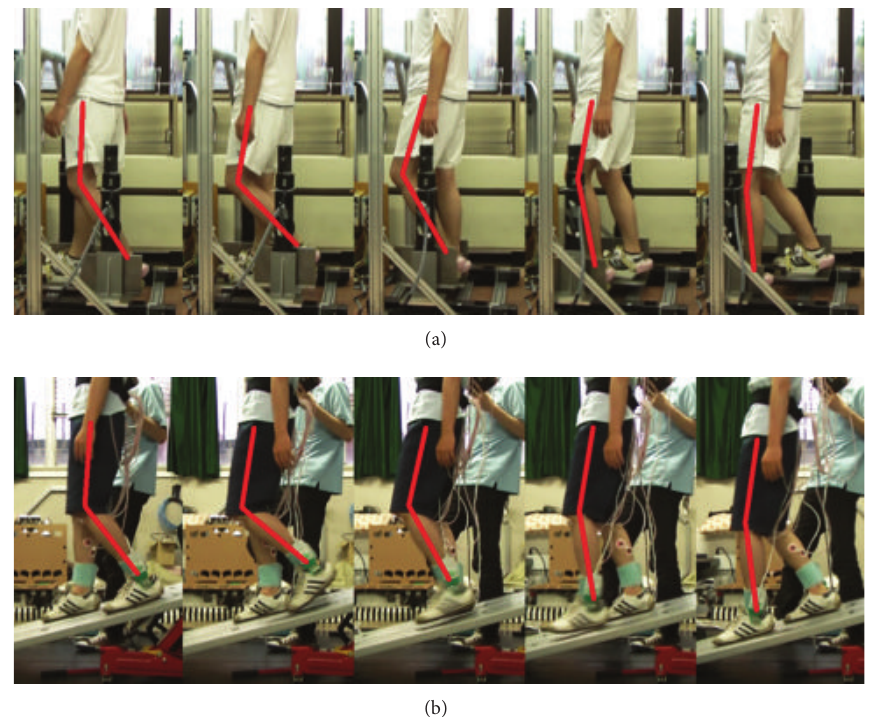
Figure 12: Typical motion during slope descending ((a) on the GMmini and (b) on a real